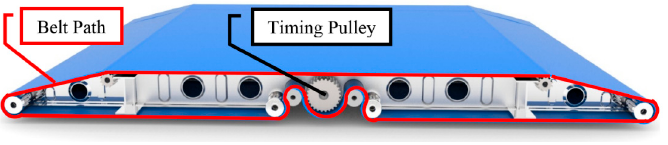
Figure 2. Timing belt path.